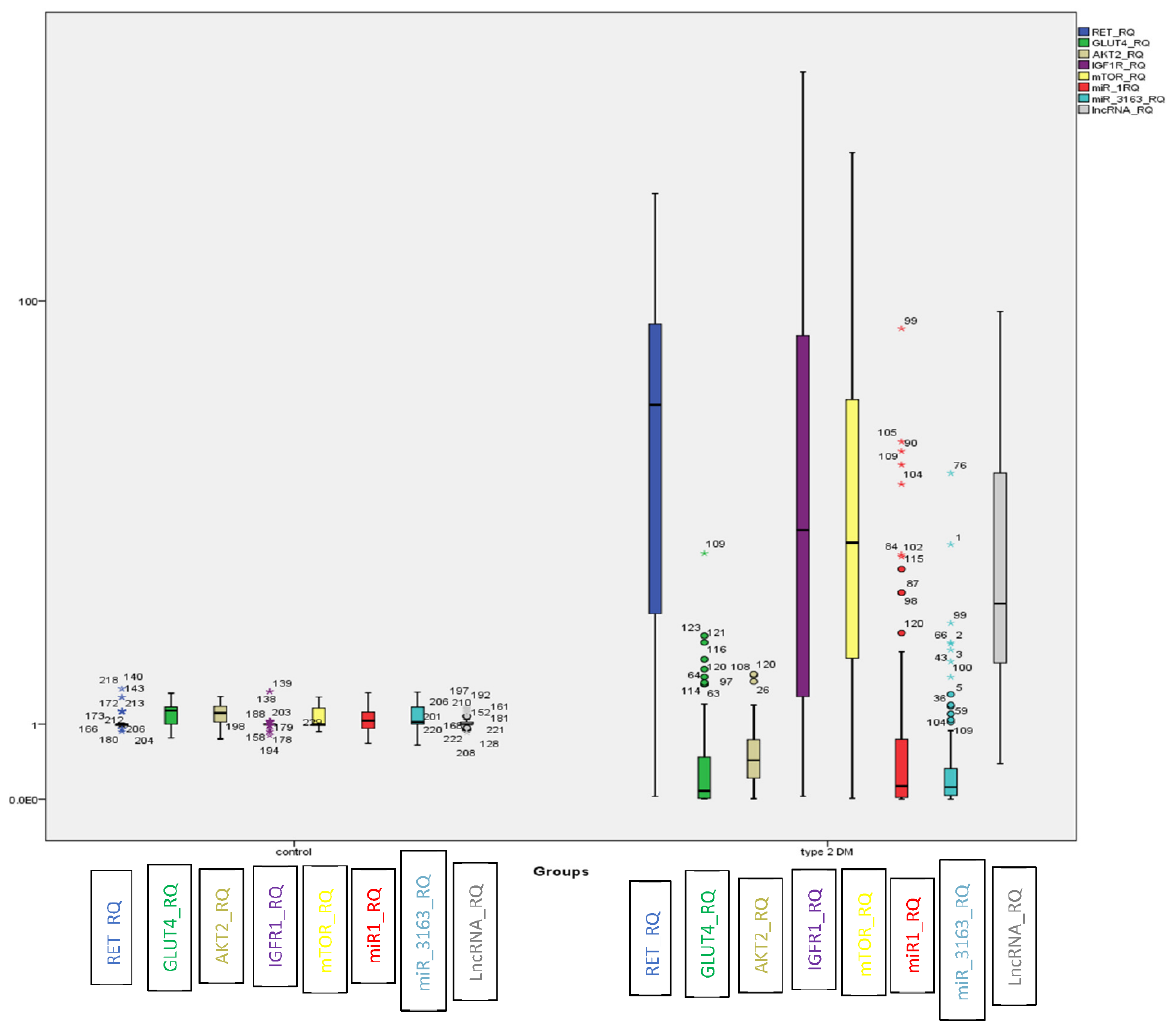
Figure 1. BOXPLOT showing differential expression of non-coding genes LncRNA-RP11-773H22.4, miR-3163 and miR-1 miRNAs and candidate genes RET, IGF1R, m-TOR, GLUT4 and AKT2 as determined by qRT-PCR in the investigated groups ((o) identify outliers and (*) identify extreme outliers).